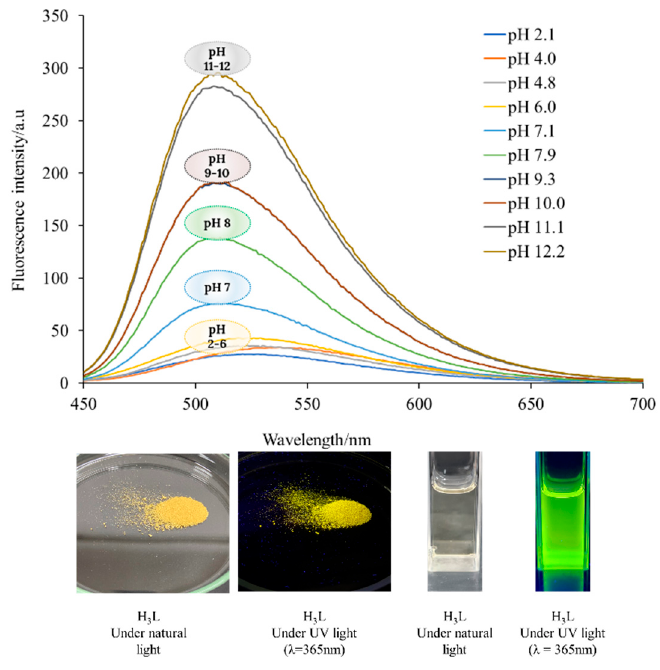
Figure 1. Top : Influence of pH on the fluorescence spectrum of H 3 L (4.44 × 10 − 4 M) measured in ethanol (pH 2.1–12.2) at room temperature. Bottom : The effect of UV light (365 nm) on an ethanol solution ( right ) and a powdery sample ( left ) of H 3